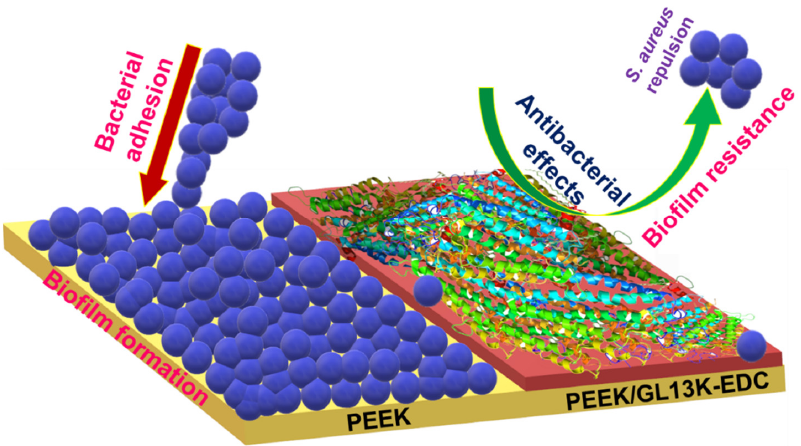
Figure 8. Schematic illustration of bacterial adhesion and the antibacterial activity with biofilm resistance using PEEK and PEEK/GL13K-EDC samples. The red arrow indicates the bacterial adhesion on pure PEEK surface and the green arrow represents antibacterial and biofilm resistance effects on PEEK/GL13K-EDC.